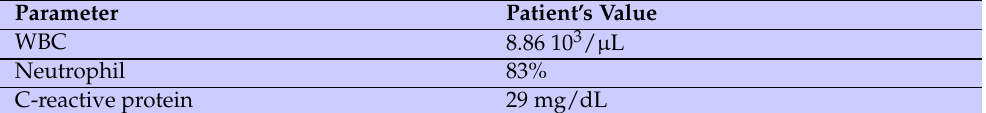
Table 3. Patient’s laboratory investigations after orchiectomy( biological